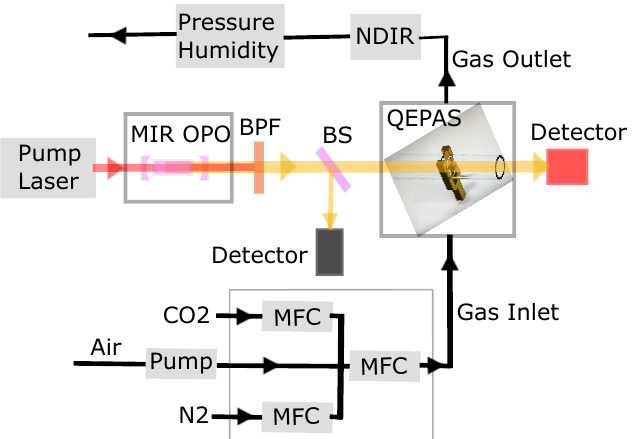
Figure 1. Block diagram of the main parts of the experimental setup. QEPAS: Quartz-enhanced PAS. MIR OPO: Mid-infrared (MIR) pulsed optical parametric oscillator. MFC: Mass-flow controller. BPF: Bandpass filter. BS: Beamsplitter. Two detectors (black: fast detector; red: thermal detector) are monitoring the optical